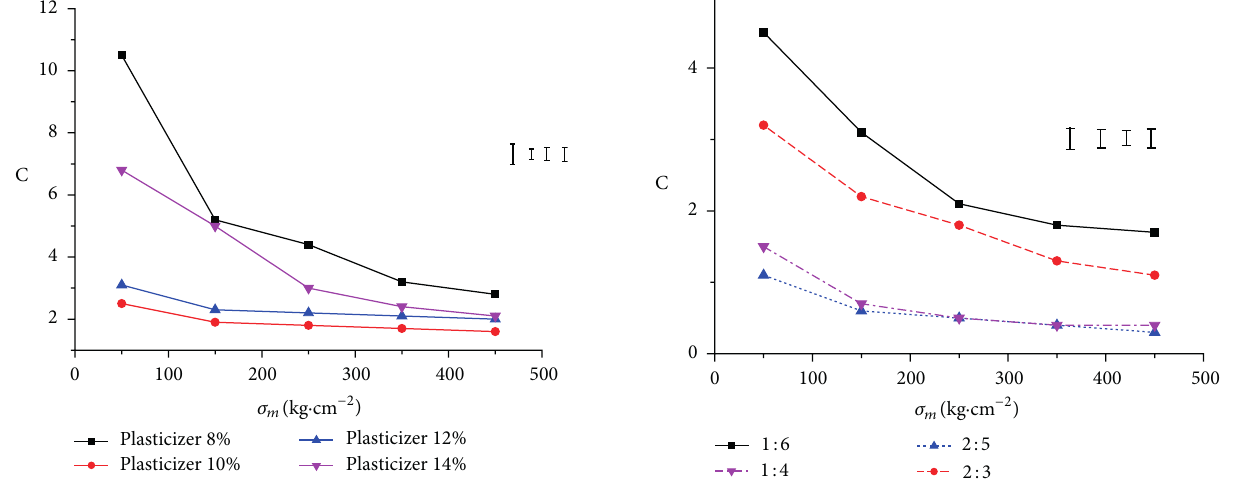
Figure 3: Cushion coefficient-maximum stress (C- 𝜎 𝑚 ) curves of different mass ratios of fiber to starch. Bars indicate mean ± average standard deviation.